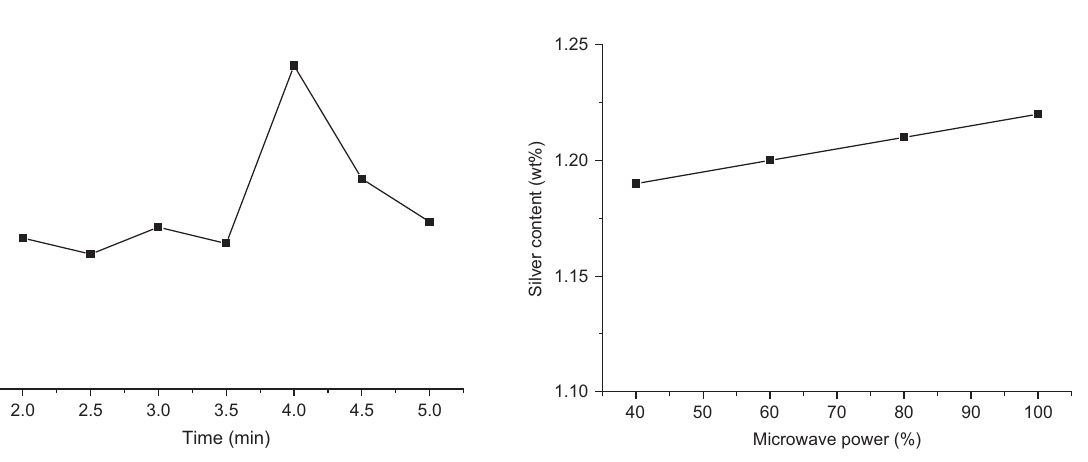
Figure 3 Effect of AgNO Ag-MMT.